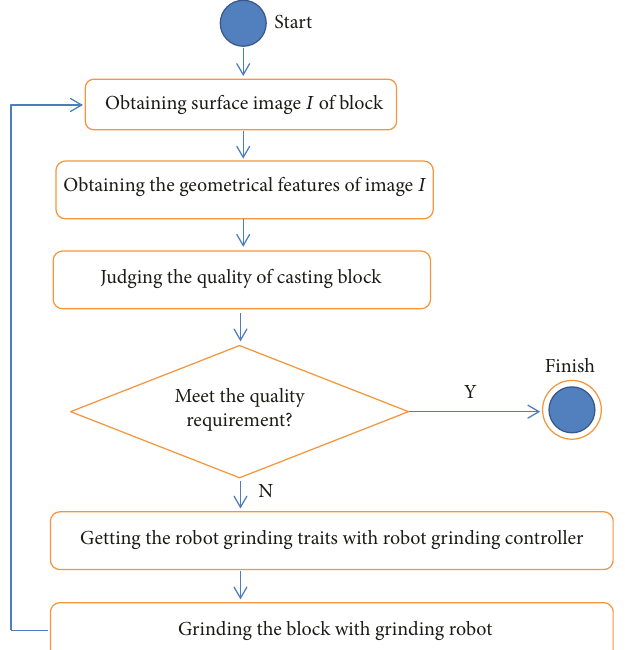
Figure 6: The working process algorithm of grinding robot controller model.